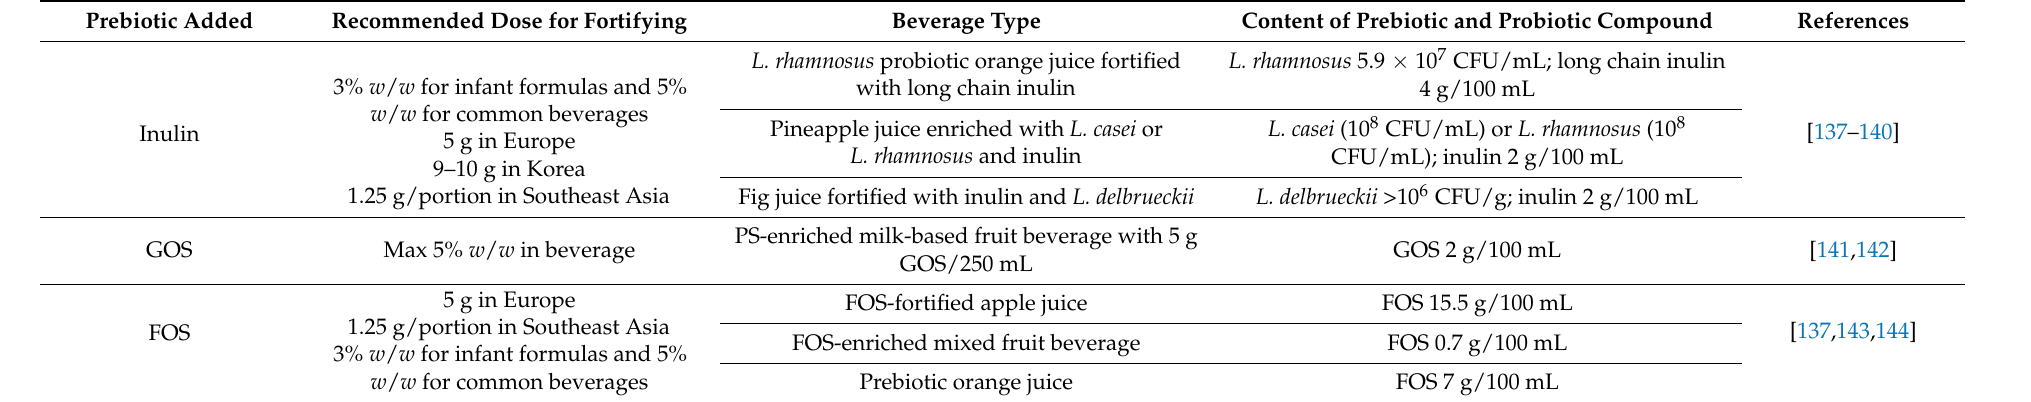
Table 2. Prebiotic and probiotic content in fruit-based fermented